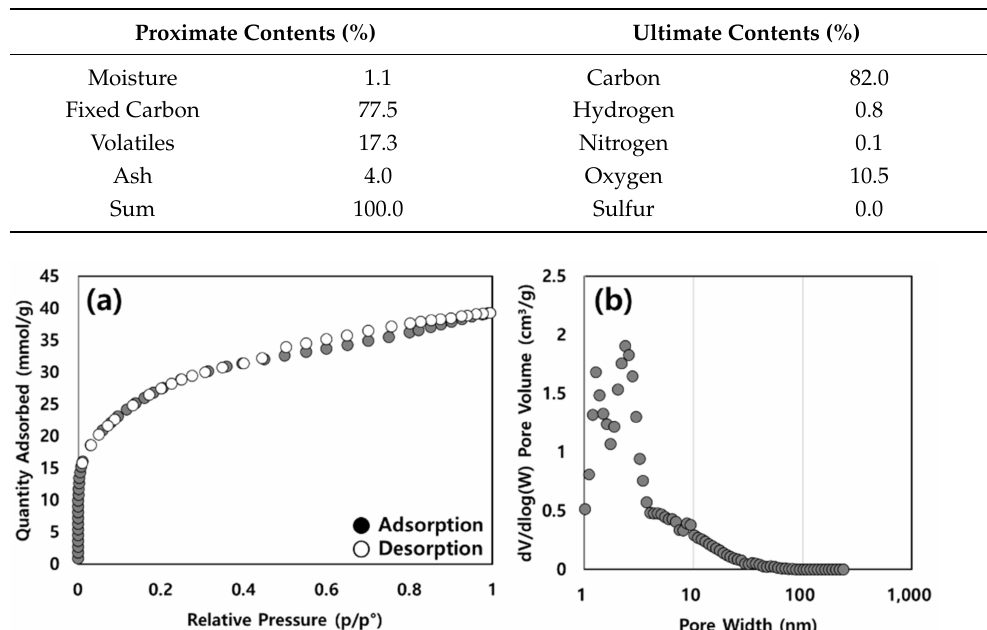
Table 1. Proximate and ultimate analyses of activated carbon.